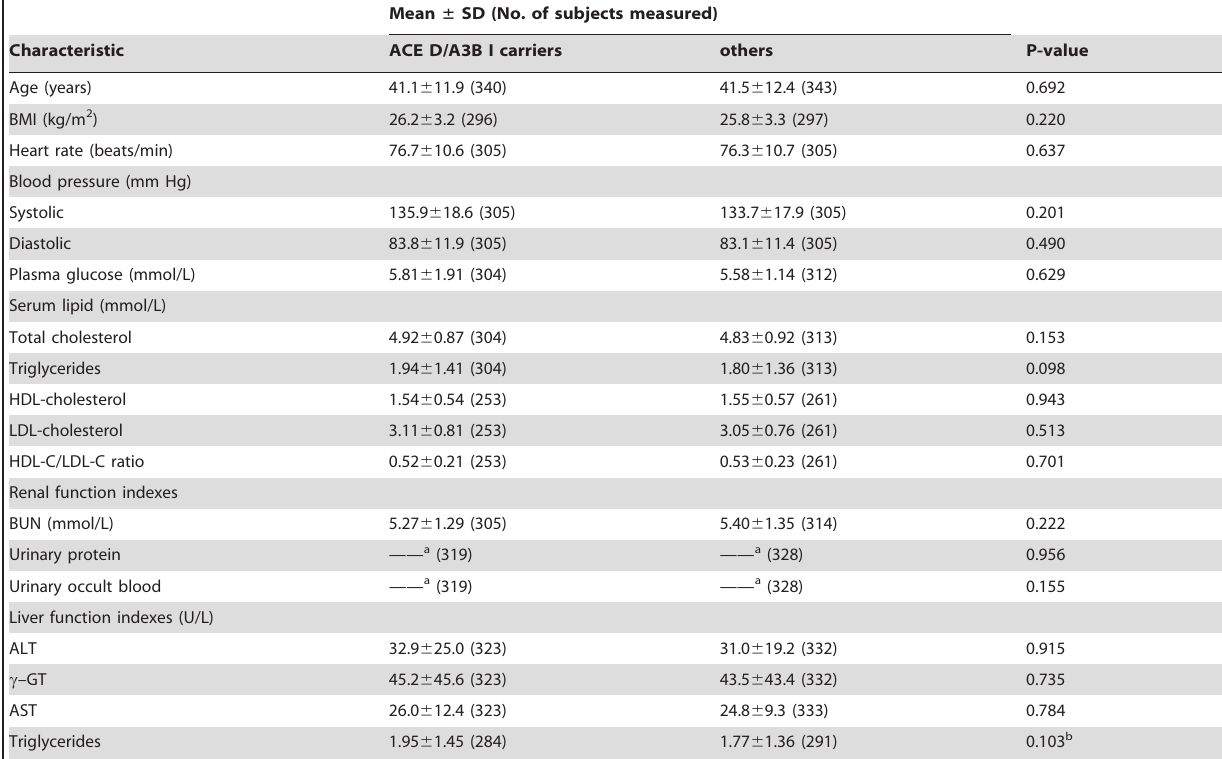
Mean ± SD (No. of subjects